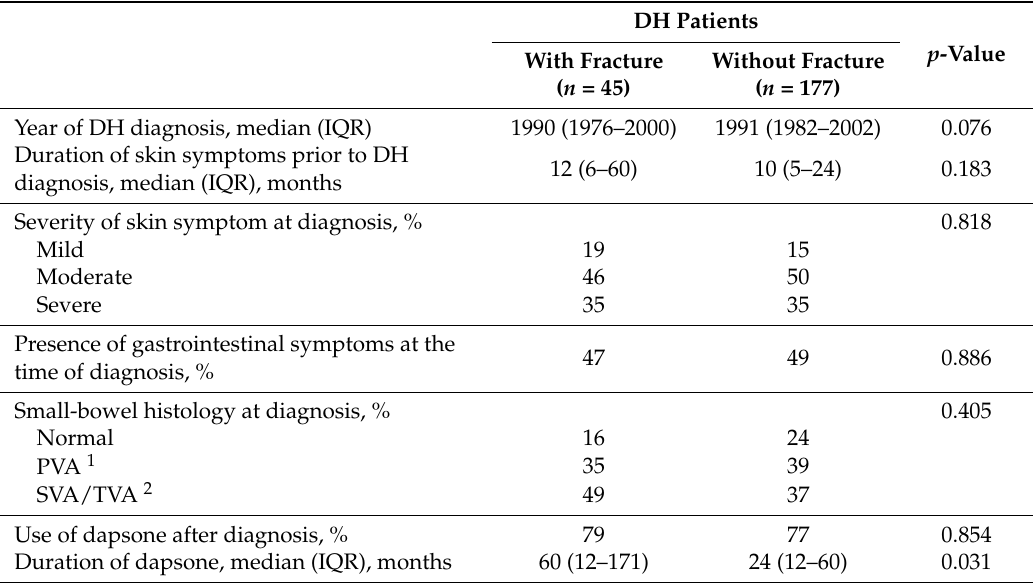
Table 3. Disease-related characteristics presented as percentages, median values, and interquartile ranges (IQR) for the dermatitis herpetiformis (DH) patients with fractures and those without fractures.